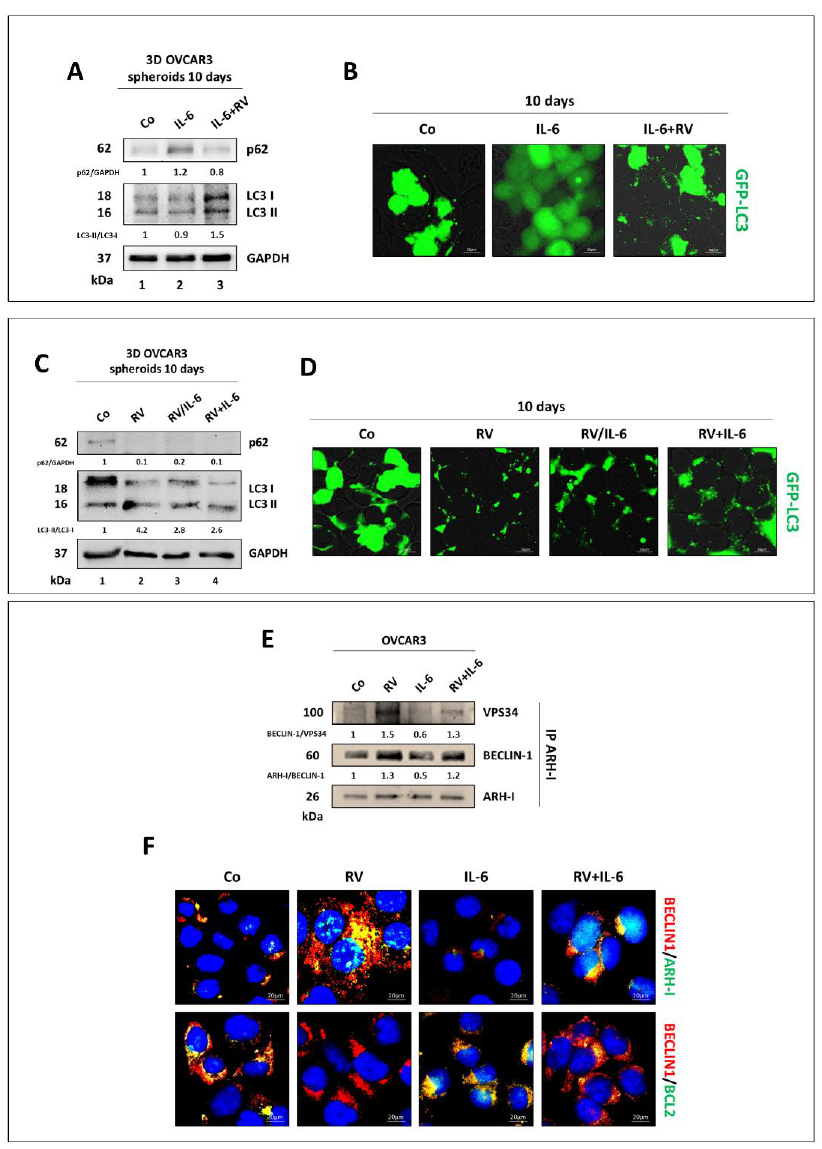
Figure 7. Resveratrol promotes an ARH-I-mediated autophagy. ( A – C ) The assessment of autophagy flux modulation in 3D OVCAR3 spheroids cultured for 10 days in the same experimental timeline of Figure 2A ( A ) and Figure 5A ( C ). The Western blotting shows the expression of p62 and the LC3- II/LC3-I ratio. The densitometric analysis of Western blotting representative of three independent experiments is included. ( B – D ) OVCAR3-GFP-LC3 cells were treated as per the experimental con- ditions reported in Figure 2A ( B ) and in Figure 5A ( D ). On day 10, coverslips were imaged with a fluorescence microscope. Scale bar = 20 µm; magnification = 63×. ( E ) Co-immunoprecipitation of ARH-I binding partners belonging to the autophagic initiation complex. OVCAR3 cells were cul- tured in 2D and treated with 100 μM RV, 50 ng/mL IL-6, or both for 24 h. The quantification of the interactions between the autophagic initiation partners is included. Data are representative of three independent replicates. ( F ) Immunofluorescence double-staining for BECLIN-1 (red) – ARH-I (green) and BECLIN-1 (red) – BCL-2 (green). Scale bar = 20 µm; magnification = 63×.